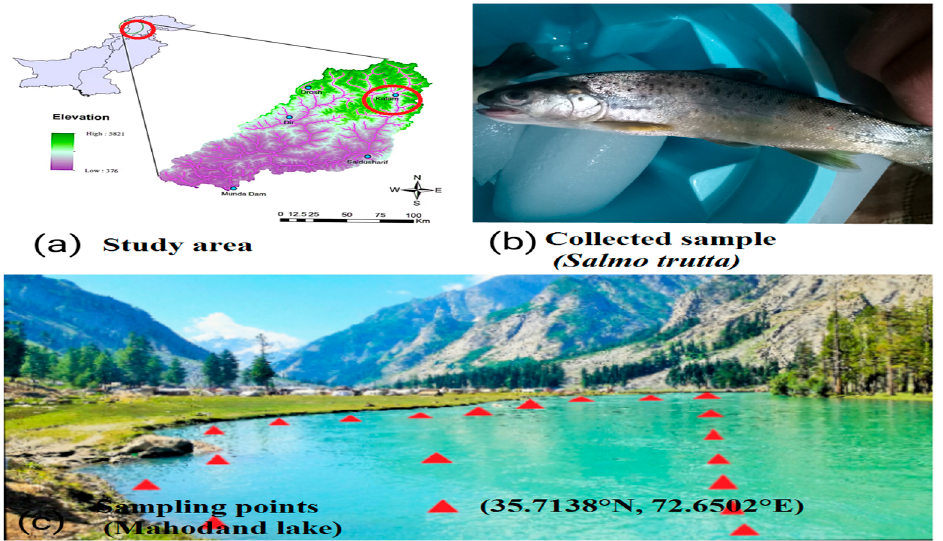
Figure 1. The study area map “( a )” sampled fish species “( b )” and sampling locations of collected fish and surface water samples “( c )”. fish and surface water samples “( c